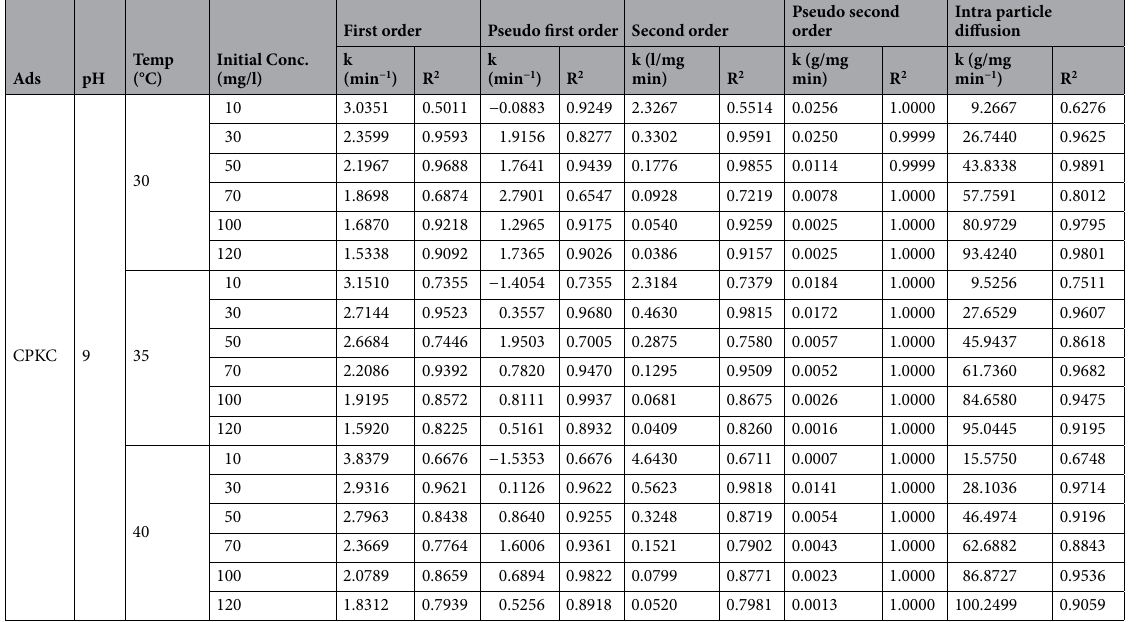
Table 4. R 2 and K values for various kinetic models for CPKC at pH 9 and Temperatures 30 °C, 35 °C and 40